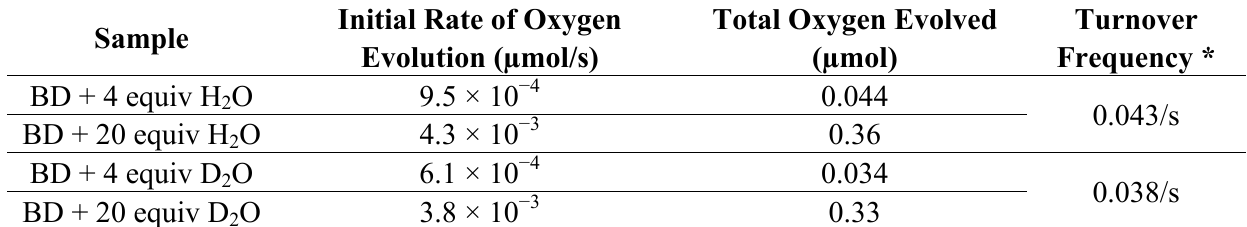
Table 1. Rate of oxygen evolution and total oxygen evolution for 0.1 mM BD in H D O solution at pH = 2